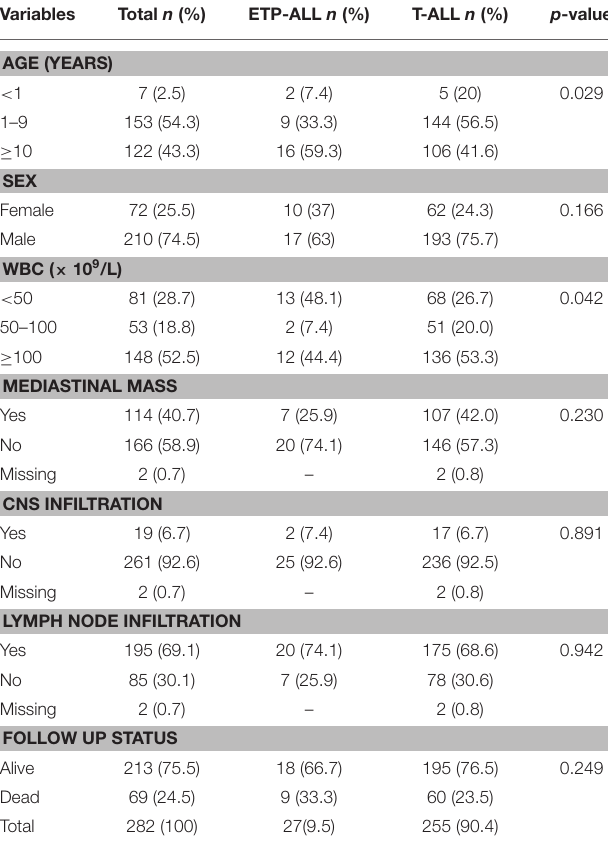
TABLE 1 | Demographic, clinical-laboratorial and molecular features of pediatric T-ALL in Brazil, 2005–2017.